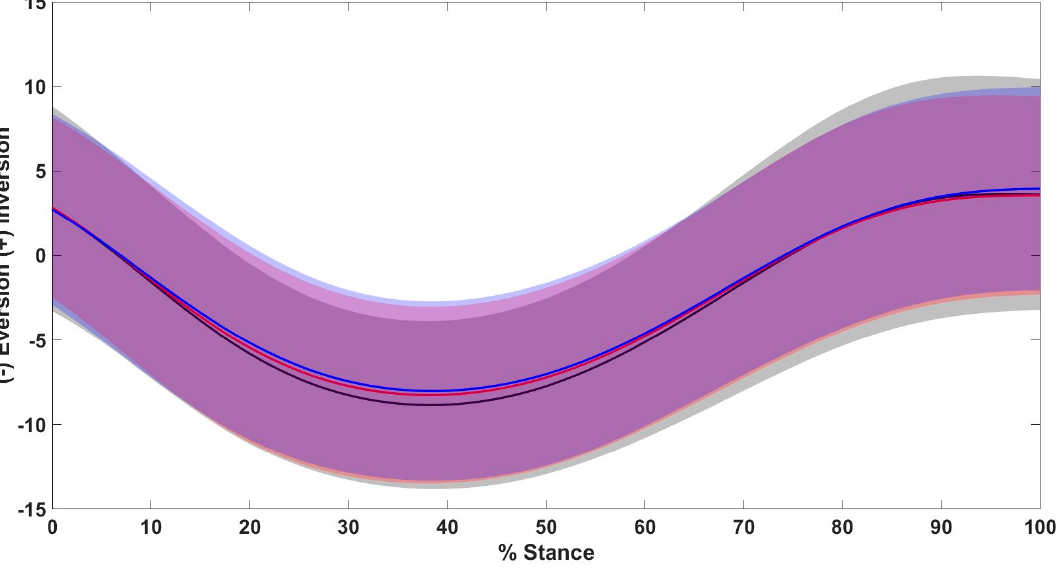
( b ) Figure 2. ( a ) Mean (solid line) and standard deviation (shaded) of the frontal plane rearfoot angle between preferred (black), +5% (red), and +10% (blue) step rate conditions. ( b ) t -values of SPM post hoc comparison between preferred and +10% conditions for frontal plane rearfoot angle. Dashed red lines indicate critical threshold ( α = 0.05). Gray shaded area indicates regions with statistically significant differences between the preferred and +10% condition. The transverse plane tibial rotation angle was significantly reduced in the +10% con- dition between 2.6% and 34.9% of stance ( p < 0.001) compared with the preferred condi- tion, and significantly reduced in the +10% condition between 6.1% and 31.4% of stance ( p = 0.0059) compared with the +5% condition (Figure 3).